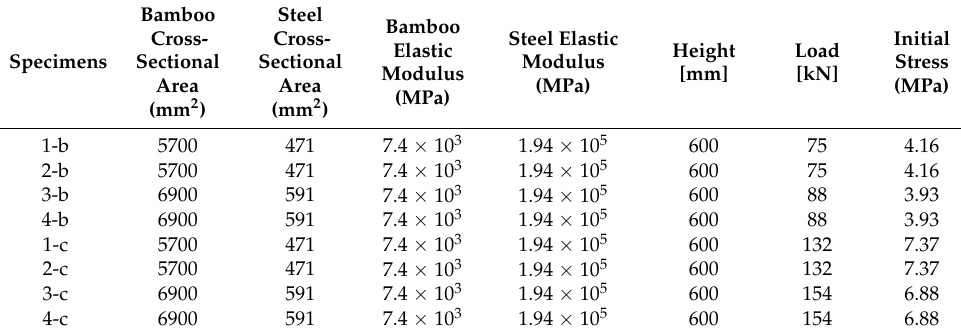
Table 5. Initial parameters of long-term loading